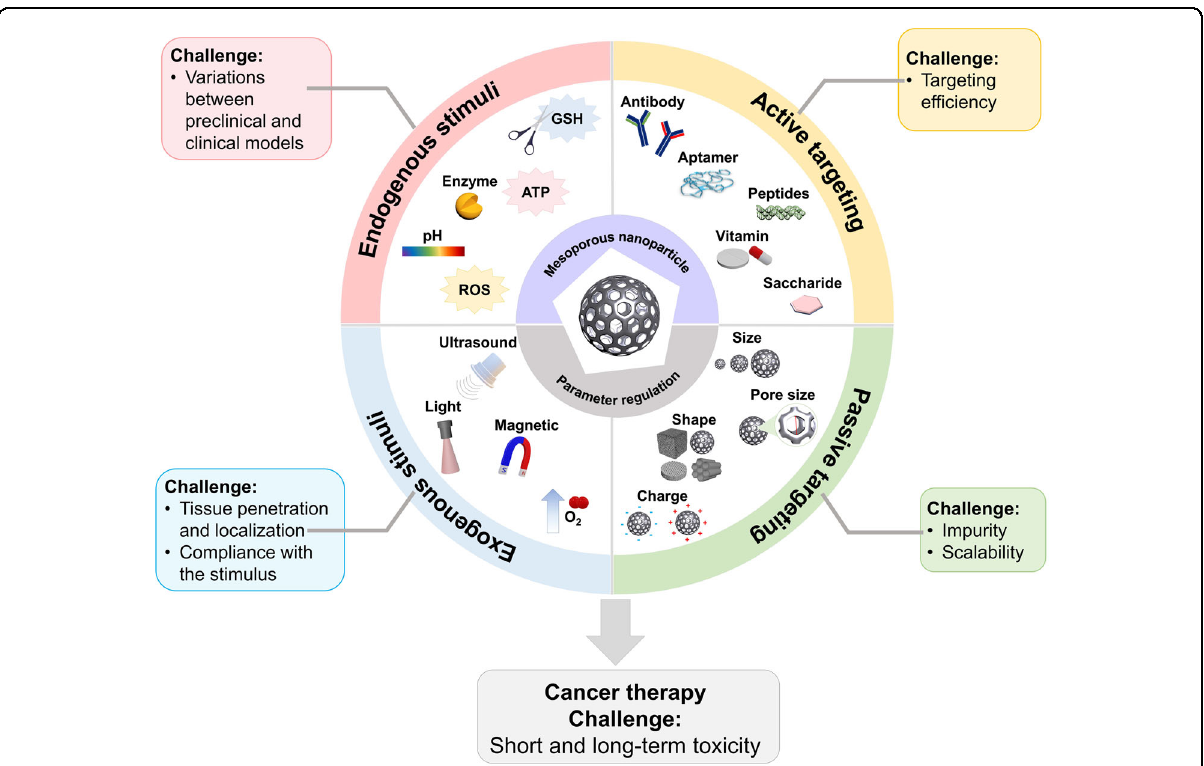
Fig. 9 Design considerations for engineering mesoporous nanoparticles for cancer therapy. Stimuli-responsive mesoporous nanoparticles improve the speci fi city of drug delivery in tumor microenvironments or inside cancer cells for on-demand drug accumulation and delivery. To effectively improve its potential use in the clinical trials, there are several challenges that should be taken into considerations, such as targeting ef fi ciency, impurity, scalability, short and long-term toxicity, tissue penetration, variation between cellular, preclinical, and clinical